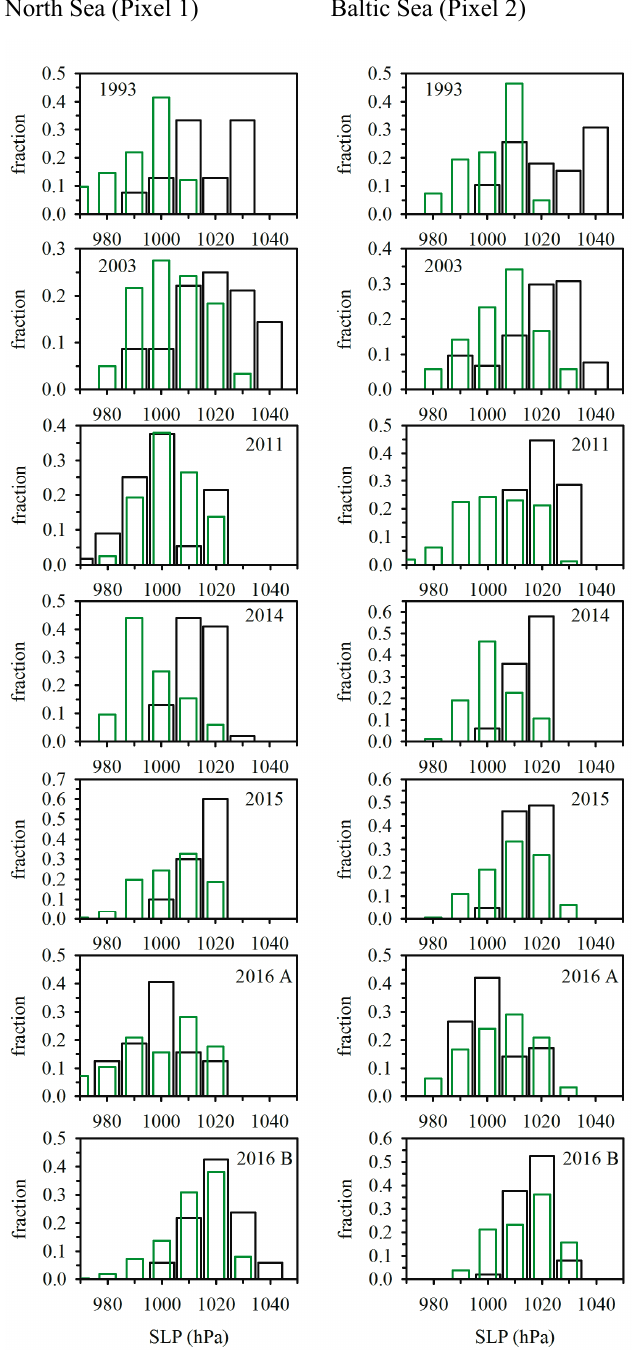
Figure 8. Frequency distribution of sea level pressure (SLP) at pixel 1 (left side panel) and pixel 2 (right side panel) during inflow events. Data from the outflow phase are shown in black. Data for the inflow phase are plotted in green.